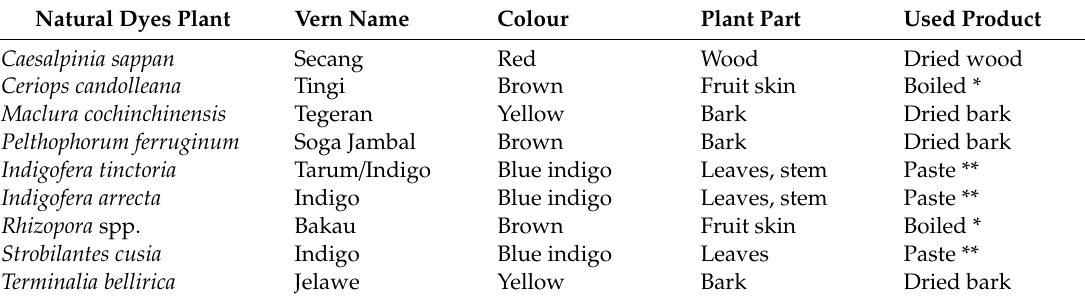
Table 1. Dye plant resources for natural batik in the Zie Batik home